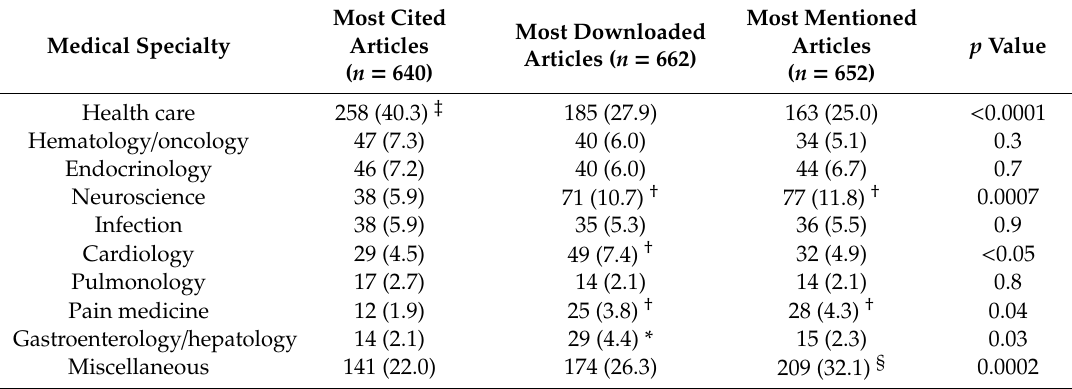
Table 1. Medical specialties of the most cited, most downloaded, and most mentioned articles published in general medical